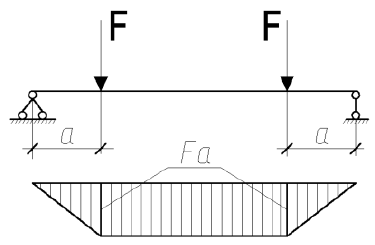
Figure 7. The 2-m long beam calculation scheme with a moment diagram The distance a is 0.4 m. A 2-m long beam is hinged at the ends and loaded at the same distance of 0.4 m